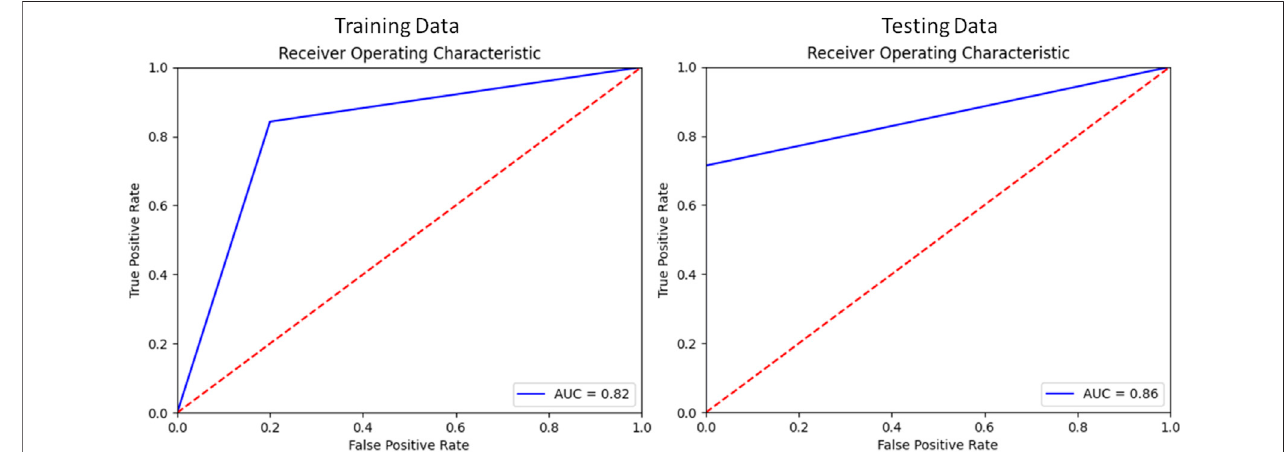
FIGURE 5 | Receiver Operator Characteristic of the Classi fi cation model for Training and Testing splits.